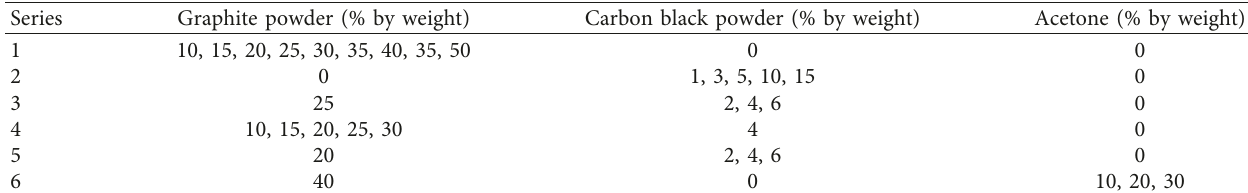
Table 2: Phantom materials and their weight percentage used to prepare a series of samples to determine the most suitable composite to mimic the individual solid phantom layers of the human head physical model. For simplicity, the polyurethane rubber (% by weight) is omitted.